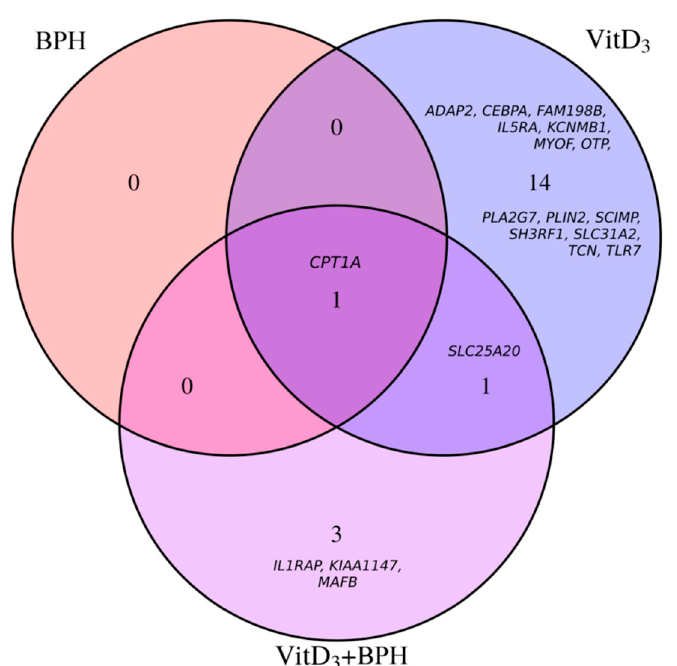
Figure 2. Venn diagram of treatment-regulated genes. Venn diagram showing the overlap of di ff erentially expressed transcripts for the bonito fish peptide hydrolysate (BPH), vitamin D 3 (VitD 3 ) and the vitamin D 3 + bonito fish peptide hydrolysate (VitD 3 + BPH) treatments. Number of di ff erentially expressed transcripts and gene symbols are provided.